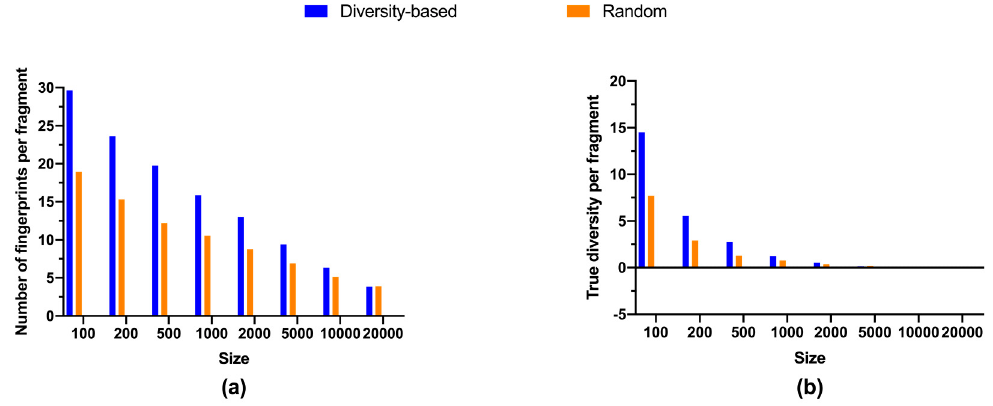
Figure 4. Efficiency in adding diversity: ( a ) average number of unique fingerprints (richness) per fluorinated compound; ( b ) average value of true diversity per fluorinated compound. Metrics for random selections are average values of triplicates.